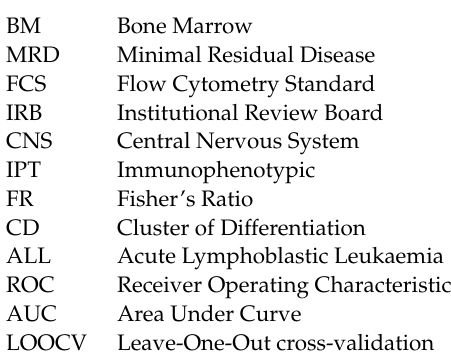
Figure S2: Standard deviation of immunophenotypic markers for relapse and non-relapse patient, Figure S3: Markers with significant differences in parameters coming from intensity profiles fitting, Figure S4: Example of curve fitting of CD38